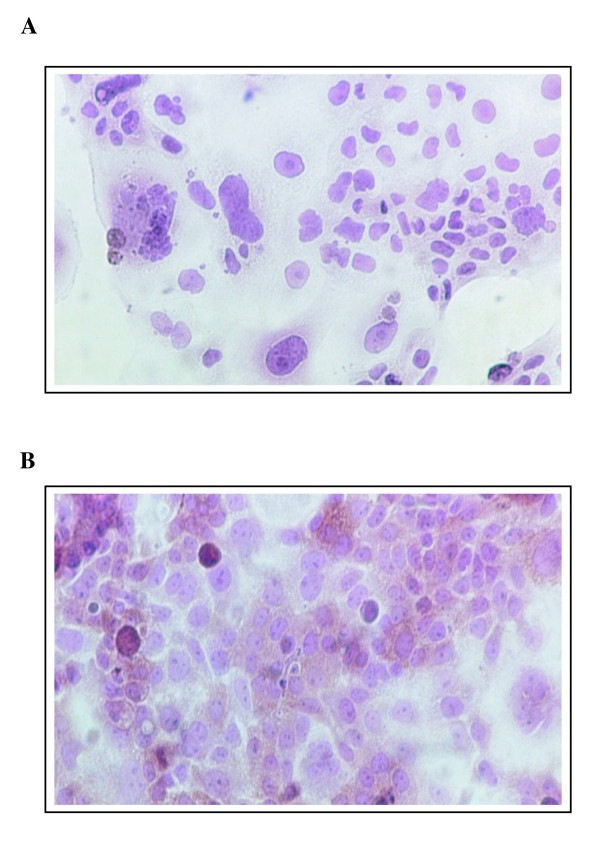
Detection of HSV-TK protein. DHDK12 cells (A) and DHDK12 cells transduced with the HSV-tk retroviral vector (B) were immunostained for HSV-TK. Cells seeded on chamber were transduced with TG 9344. After 48 hr, cells were fixed with 4% paraformaldehyde and stained with a mouse monoclonal 4C8 antibody against HSV-TK protein.